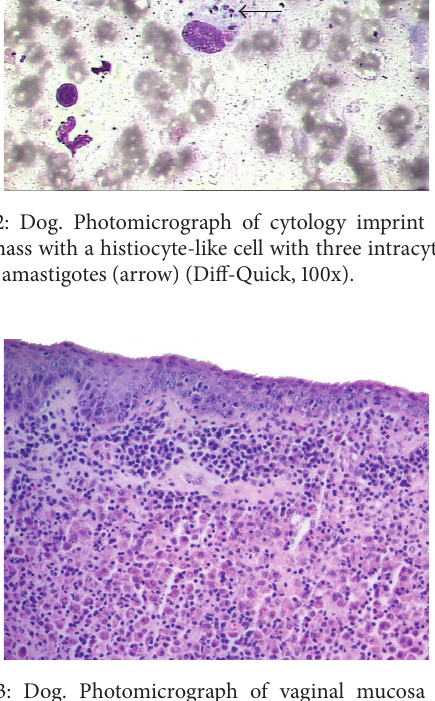
Figure 3: Dog. Photomicrograph of vaginal mucosa with the subepithelial stroma effaced by canine transmissible venereal tumor cells, mixed with macrophages and with a mild diffuse lymphoplas- macytic infiltrate (H&E, 20x).